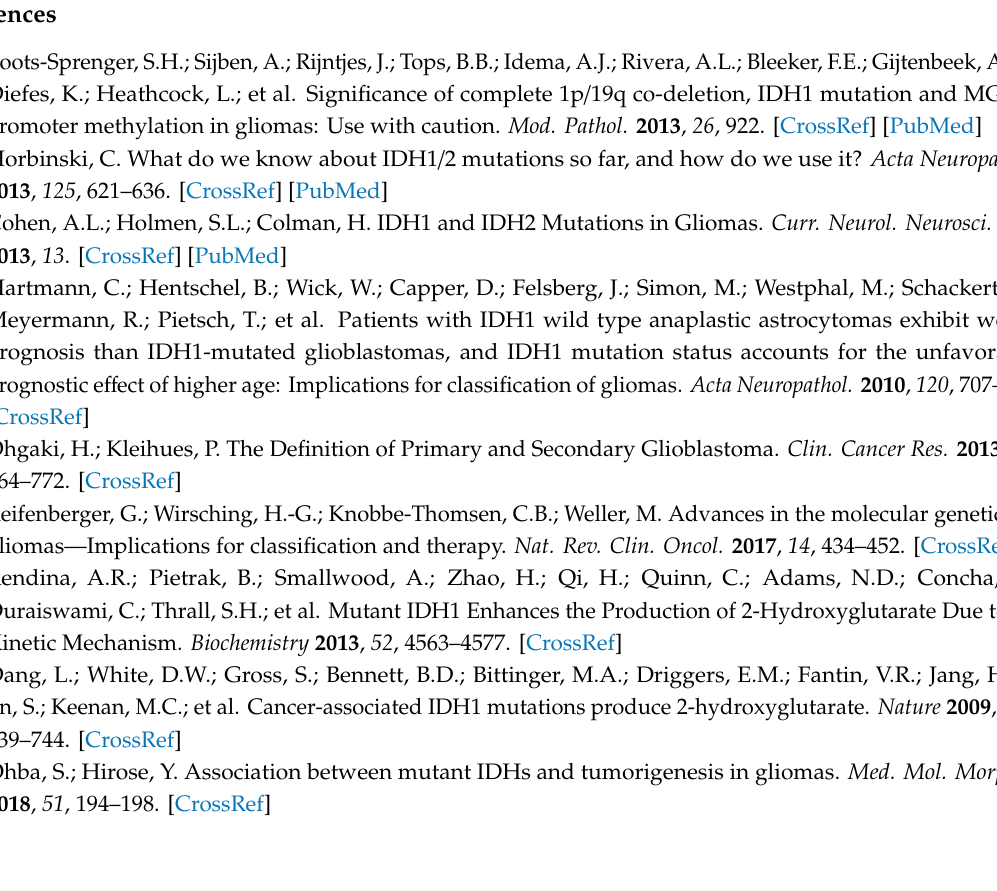
Figure S1. PCA-based quality test: PCA scores plot of PC1 and PC2 before selection of central cluster. Figure S2. (a) Absorbance spectrum of blank CaF 2 substrate and (b) raw sample spectra a ff ected by change in absorbance baseline < 1200 cm − 1 . Figure S3. Confusion matrices showing the predictions of two of the randomly selected test sets in from the linear discriminant analysis classification. Figure S4. The loadings plot for the 1 st PLS component highlighting di ff erences between IDH1 -mutated and IDH1 -wildtype, for the < 3 kDa serum filtrate (4000–800 cm − 1 ) dataset. Figure S5. Random forest Gini importance plots for the < 3 kDa filtrate datasets, showing the most important wavenumbers responsible for the IDH1 -muated versus IDH1 -wildtype classifications; (a) 4000–800 cm − 1 , (b) 1800–800 cm − 1 and (c) 1800–1000 cm − 1 . Table S1. Samples included in the centrifugal filtration of serum study. Table S2. Samples included in the synchrotron-based tissue microarray study. Table S3. Top 50 LDA models from pre-processing grid search, based on Kappa score. Table S4. Top 10 LDA models from pre-processing grid search, with sensitivity and specificity results from 51 resamples. Optimal results in